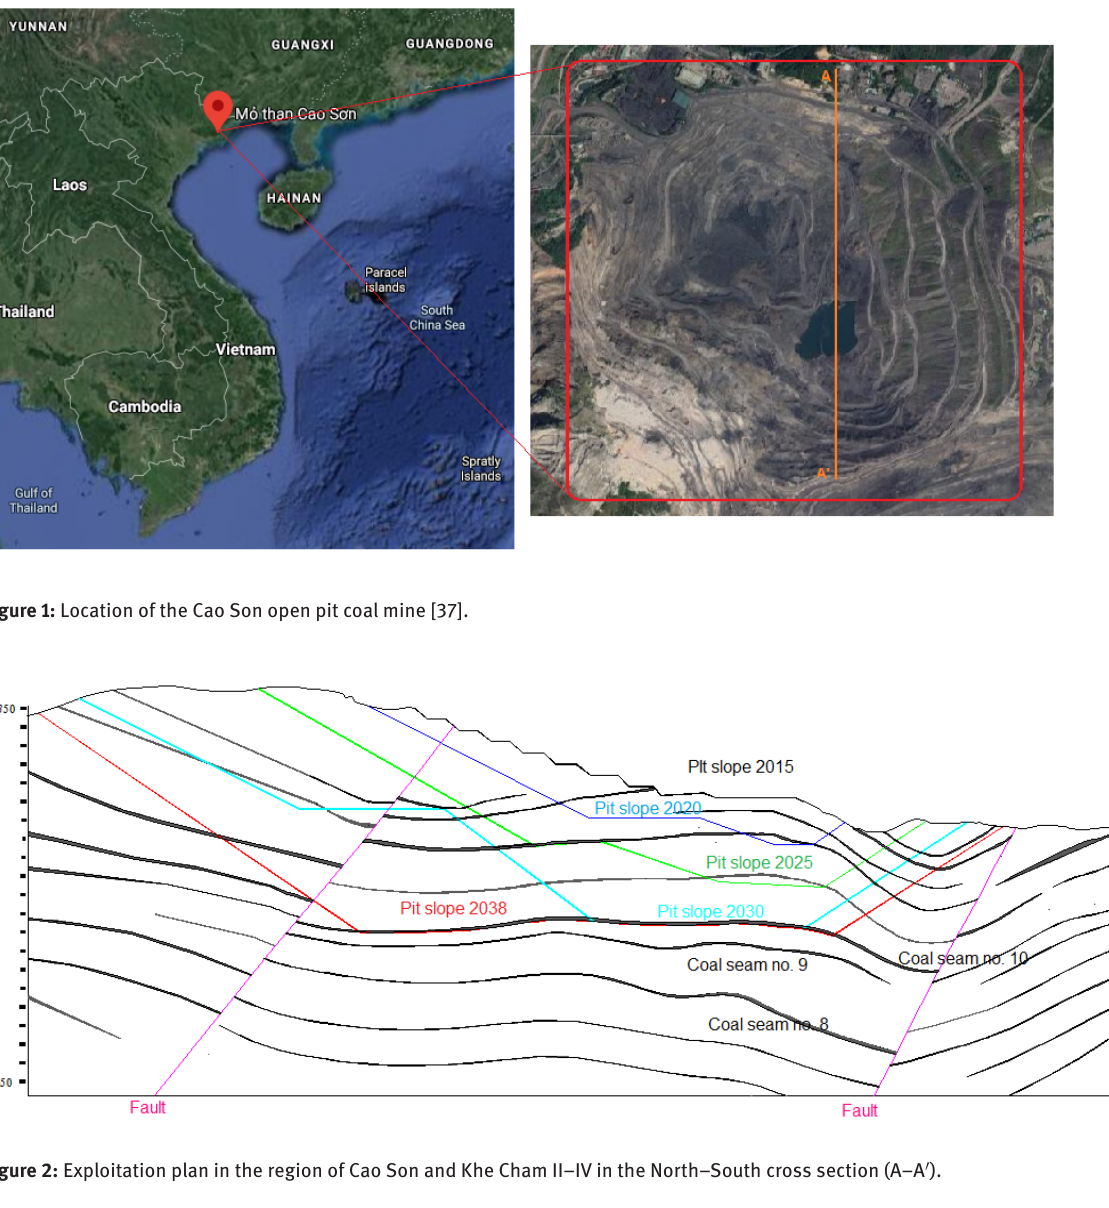
Figure 2: Exploitation plan in the region of Cao Son and Khe Cham II–IV in the North–South cross section (A–A ¢ ).